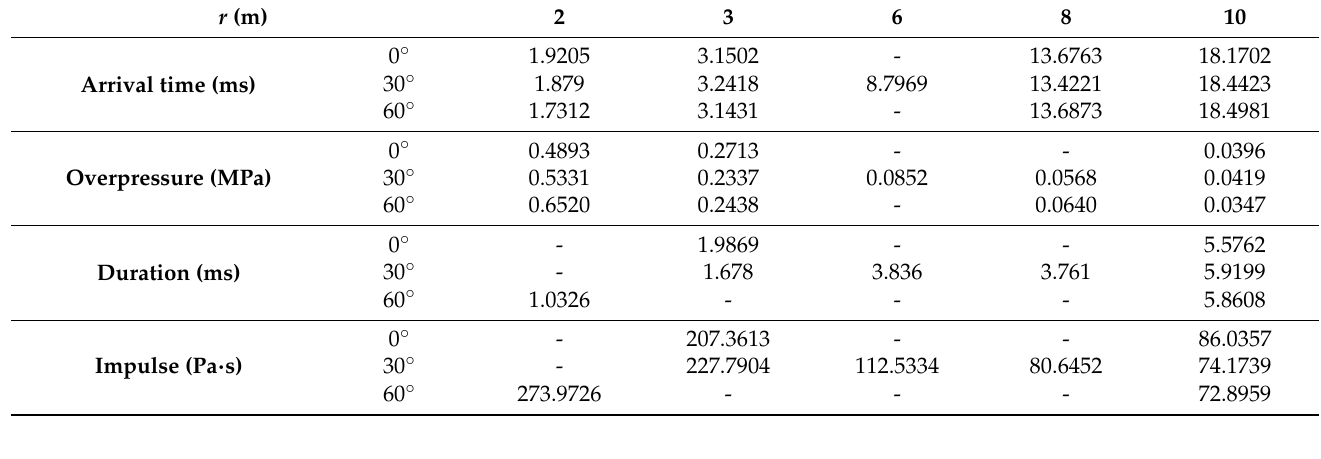
Table 3. Shock wave pressure parameters of a stationary charge explosion.